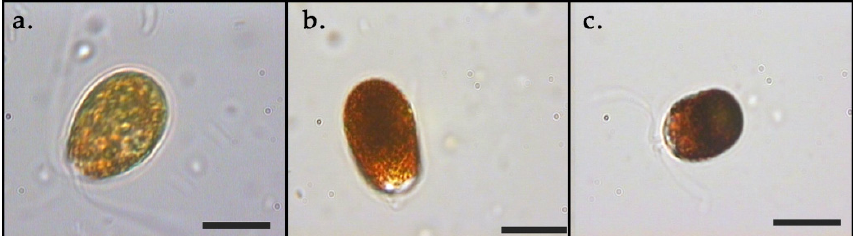
Figure 1. Living cells of the studied strains: ( a ) Dunaliella salina CCAP 19/18, ( b ) AthU-Al D30 (D30) and ( c ) AthU-Al D31 (D31). The red colouration of the cells is a result of carotenoid accumulation (S cale bar = 10 μ m).